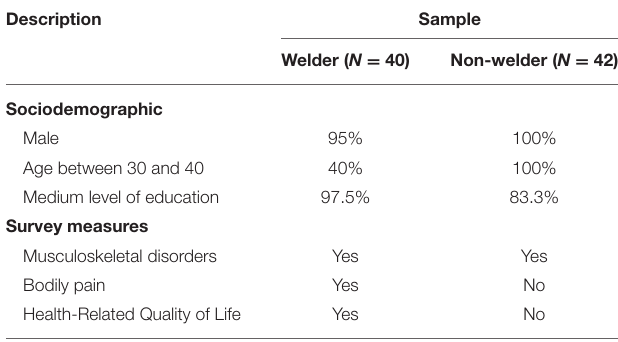
TABLE 1 | Summary of participants and